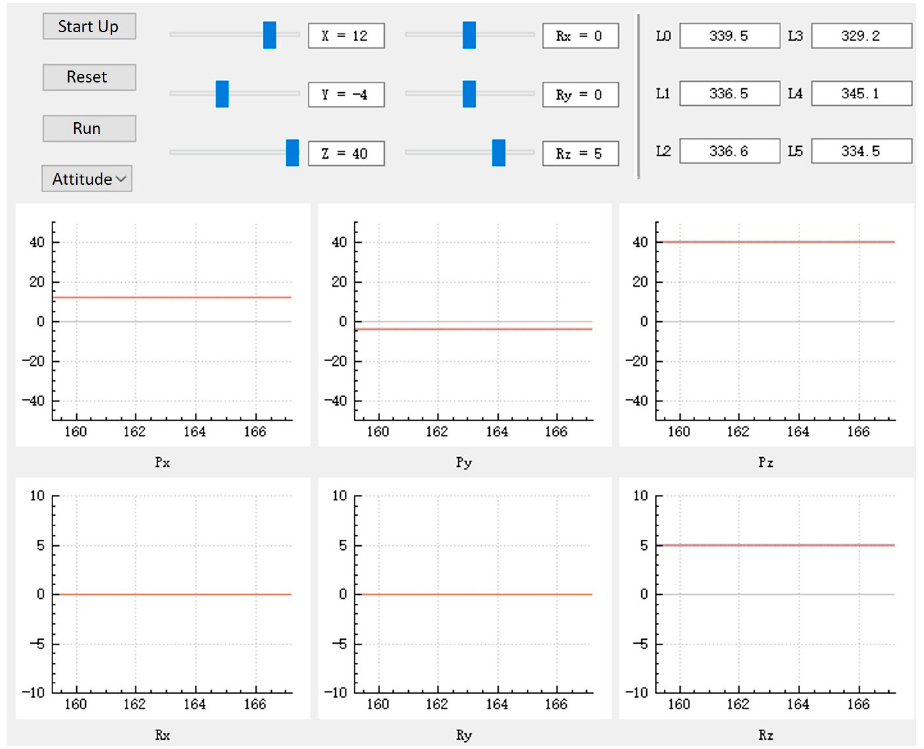
Figure 7. Set the target attitude and read the arm length.